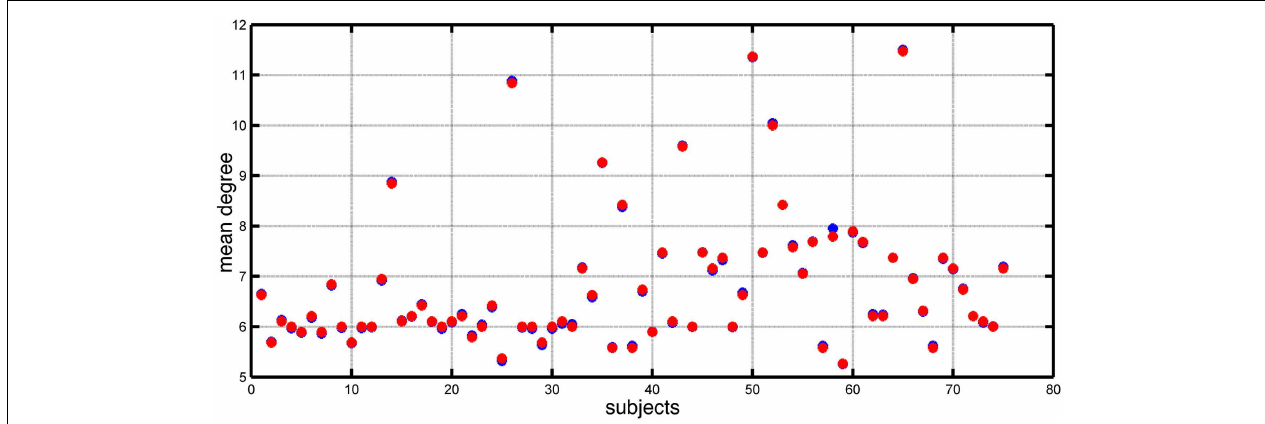
FIGURE 1 | Mean node degree values for each subject (blue dots) and each corresponding artificially constructed binary network (red dots) .